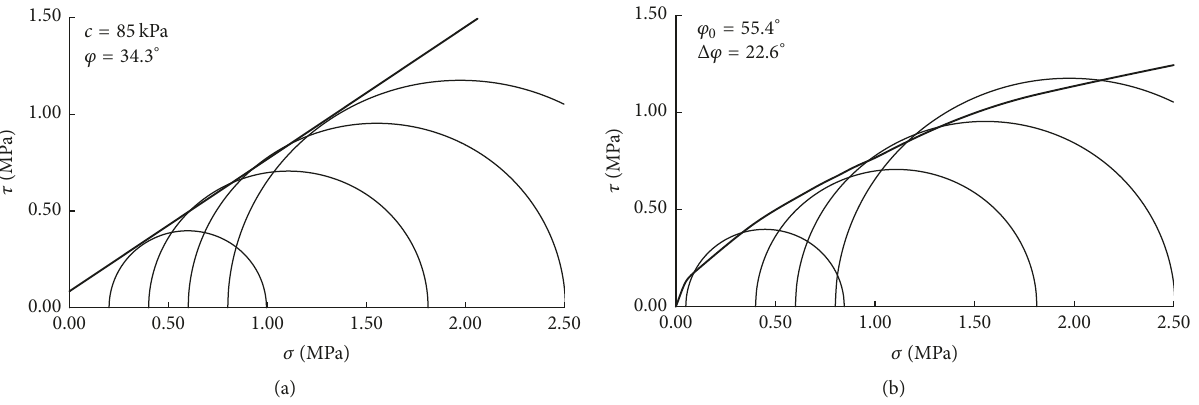
Figure 9: Strength envelope of the 70-year cemented mercury slag.